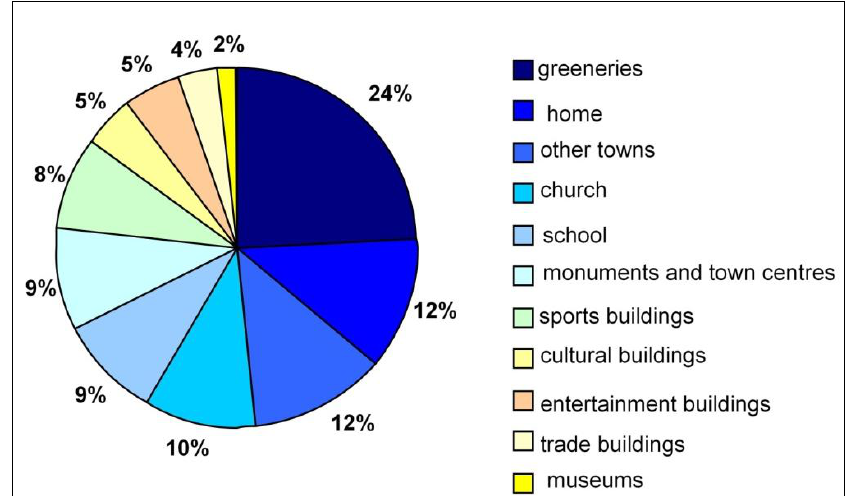
Fig. 5. Places important to the students (% of